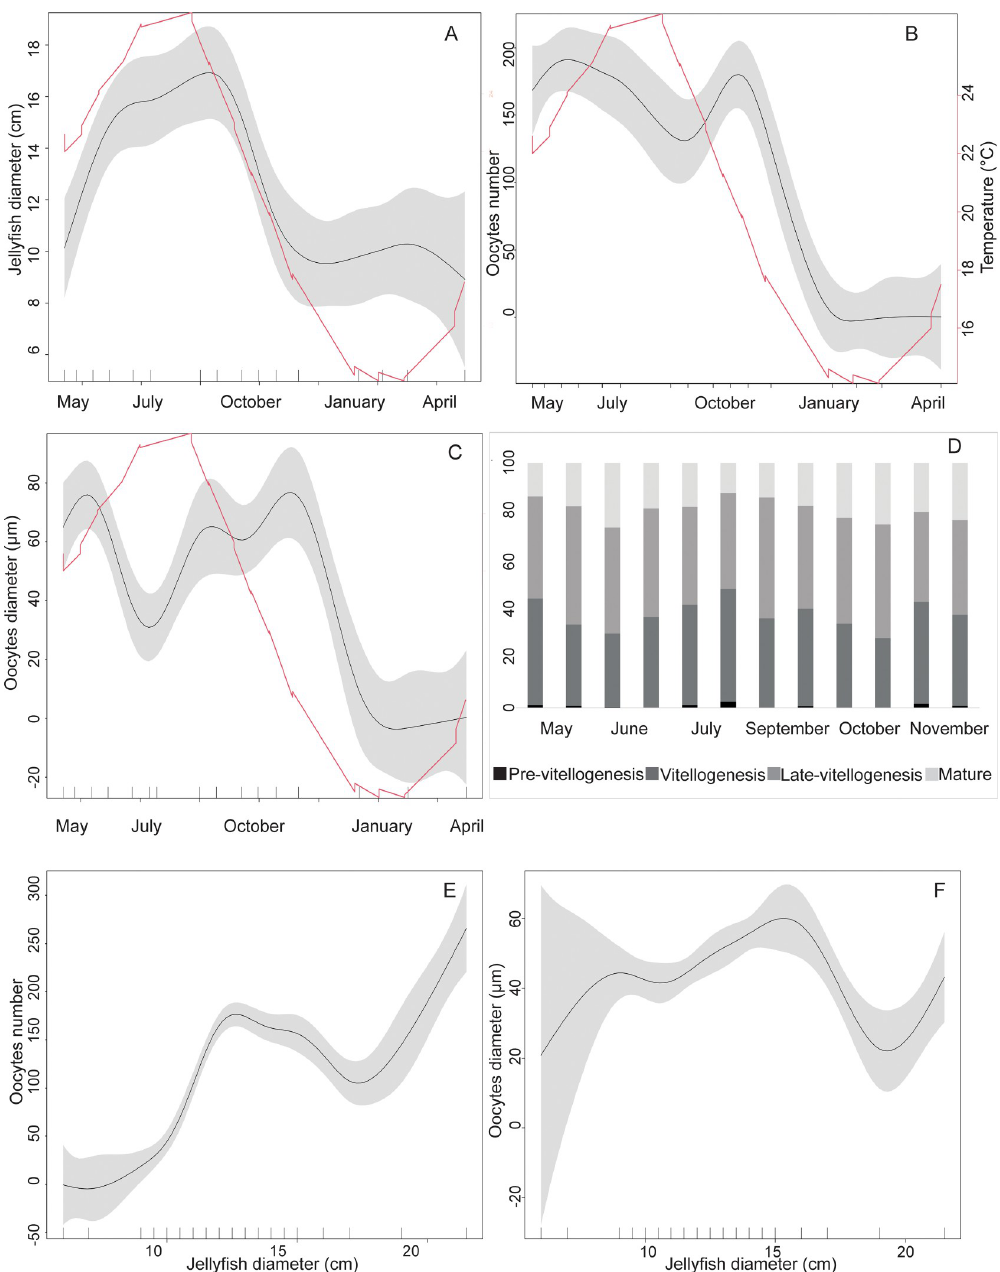
Fig 3. Representation of the temporal pattern of reproduction. (A) Jellyfish diameter (in cm) during the sampling period from May to April (B) Oocytes number per section area (mm 2 ) during the sampling period showing two seasonal peaks (late spring and autumn) and seasonal temperatures (C) Oocytes diameter during the sampling period and seasonal temperatures (D) Percentage of each oocyte maturation stage during the whole sampling period. There are two columns for each sampling date (E) Oocytes number in relation to the jellyfish diameter (F) Oocytes diameter in relation to jellyfish diameter. Graphs A, B, C, E, F: The black line represents the mean value while grey areas represent the confidence interval. Temperature is plotted in